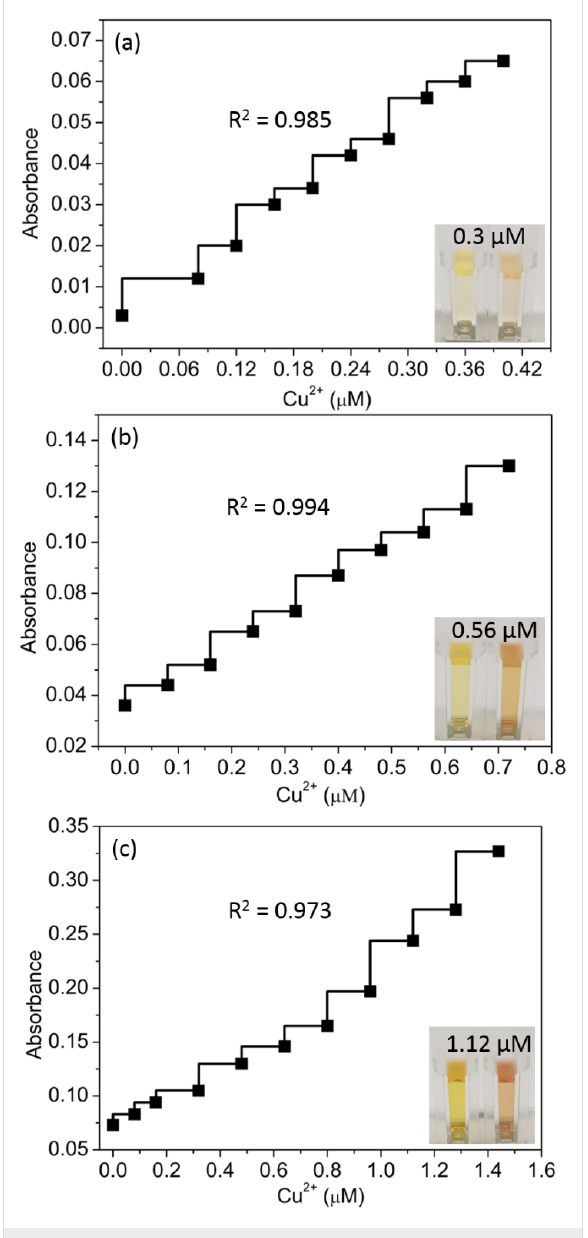
Figure 5: Absorbance intensity (at 520 nm) with increasing amounts of Cu 2+ using (a) 0.05, (b) 0.1, and (c) 0.2 mL AgNPs solution. (The visual detection limits are given in the